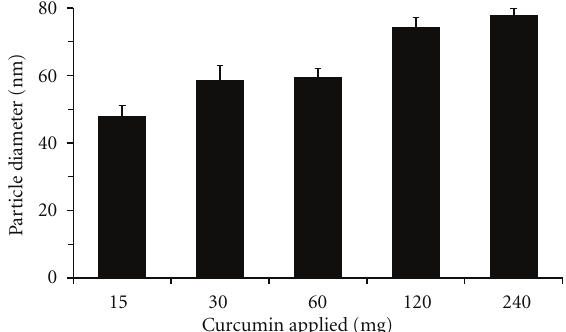
Figure 4: E ff ect of the amount of curcumin on the particle diameter of the emulsion. Formulation: 1, 5 to 8 in Table